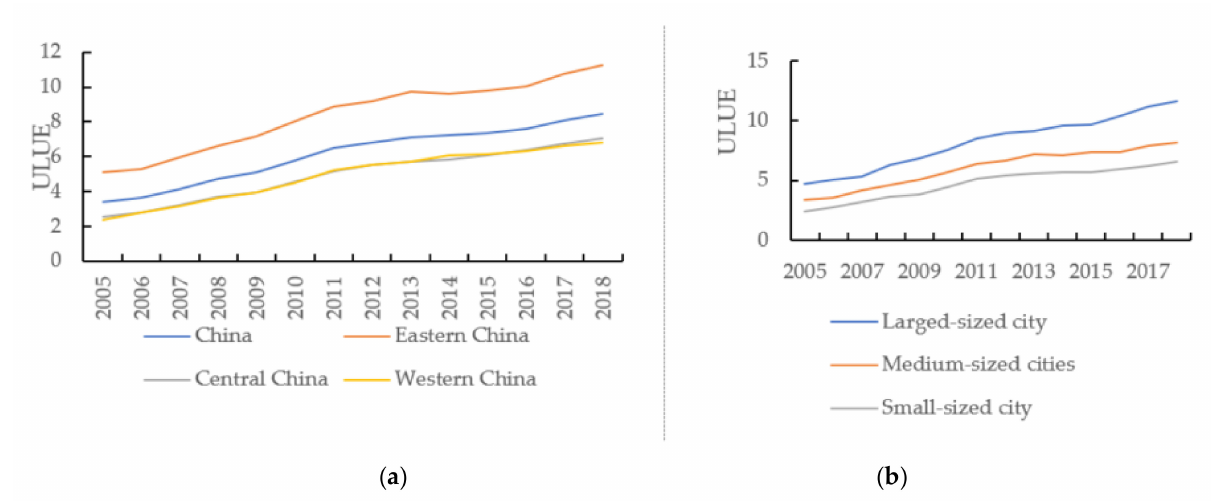
Figure 3. ( a ) Trends of ULUE in China and three major regions; ( b ) Changes in ULUE of cities for different sizes and scales.